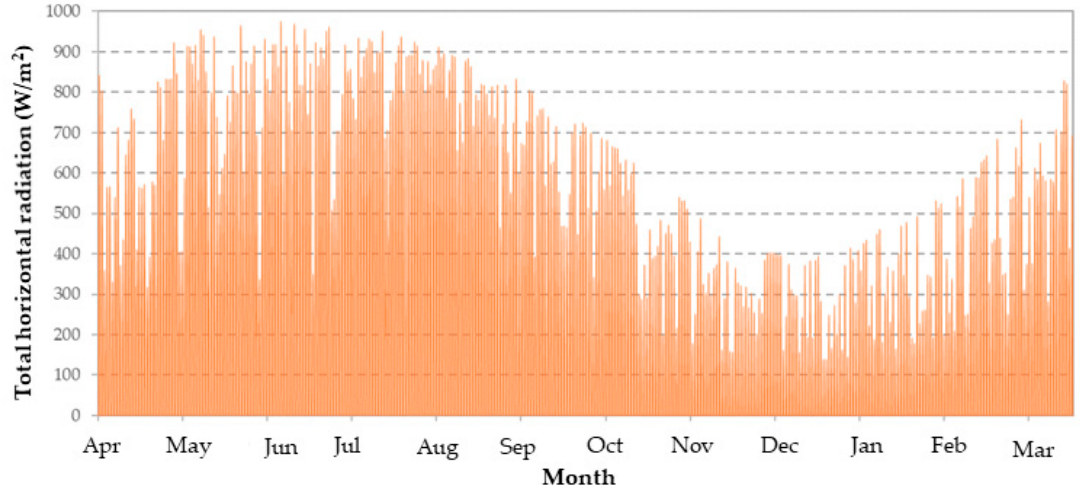
Figure 2. Annual total solar horizontal radiation trend for Naples.